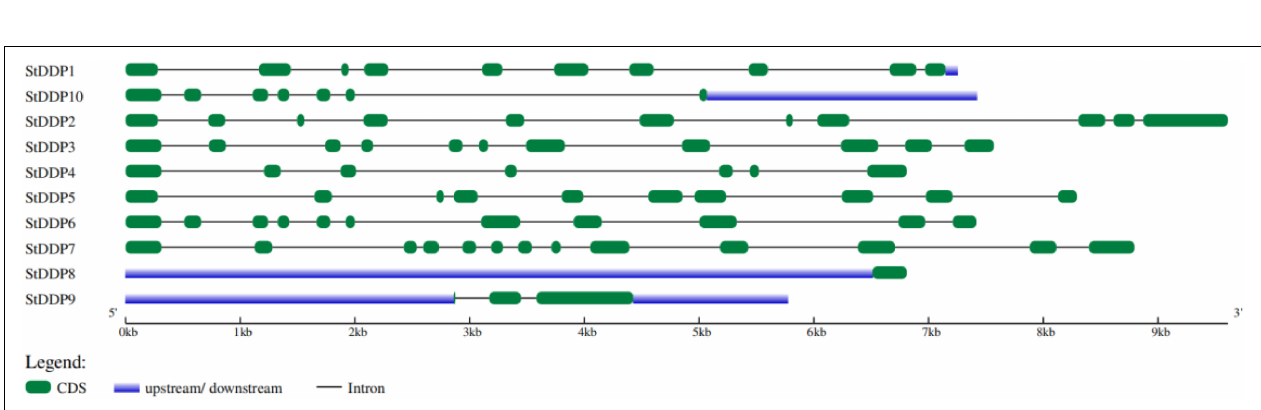
FIGURE 2 | Distribution of exons, introns, and UTR (untranslated regions) in StDDP gene sequences.